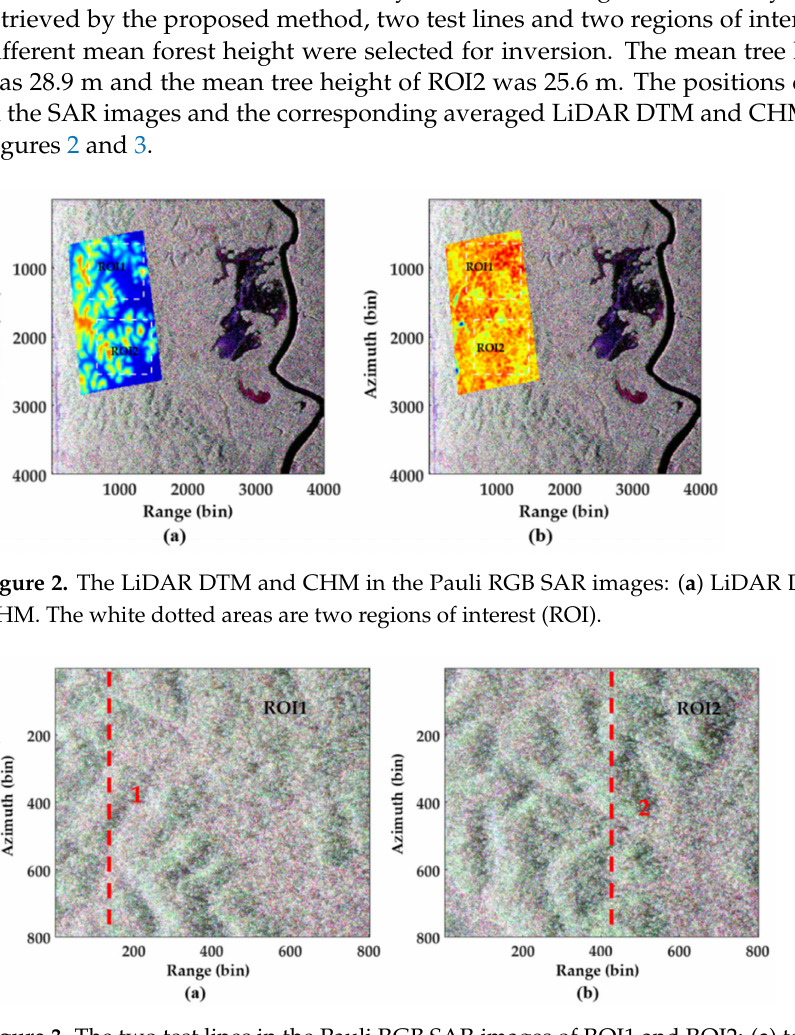
Figure 3. The two test lines in the Pauli RGB SAR images of ROI1 and ROI2: ( a ) test line1 in ROI1; ( b ) test line2 in